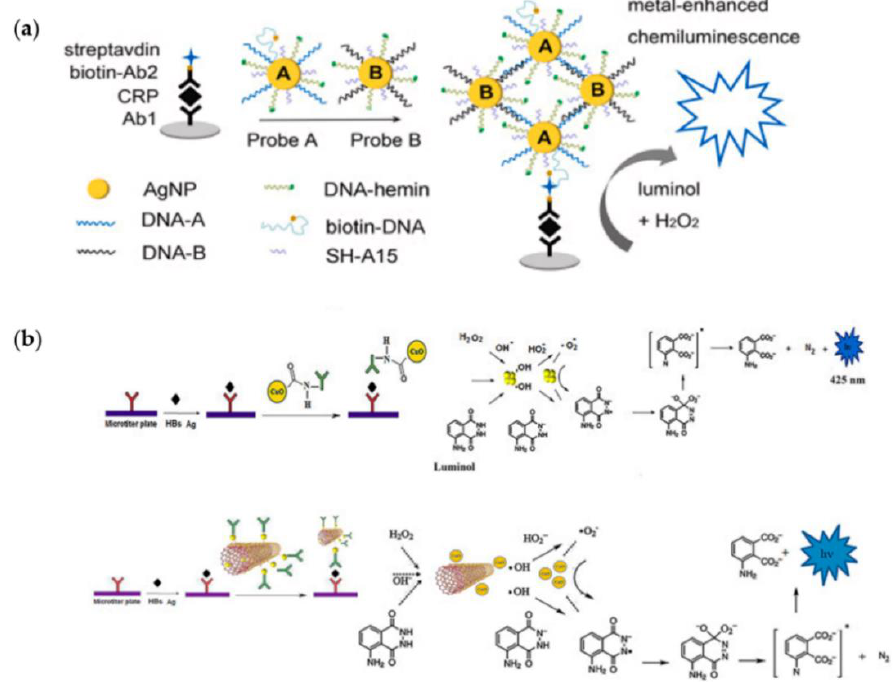
Figure 2. Nanomaterials for CL signal enhancement: ( a ) a novel silver nanoparticle hybrid probe